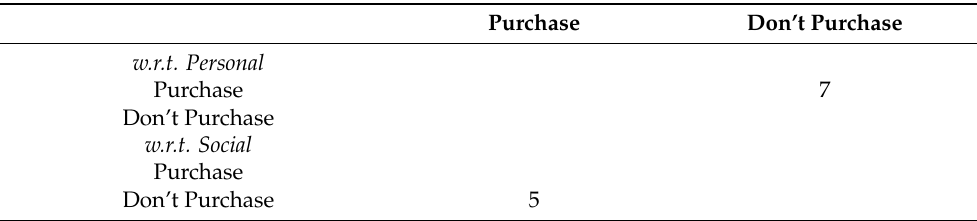
Table 14. Pairwise comparison matrix of Purchase and Don’t Purchase decision with respect to sub-criteria of EMOTION.